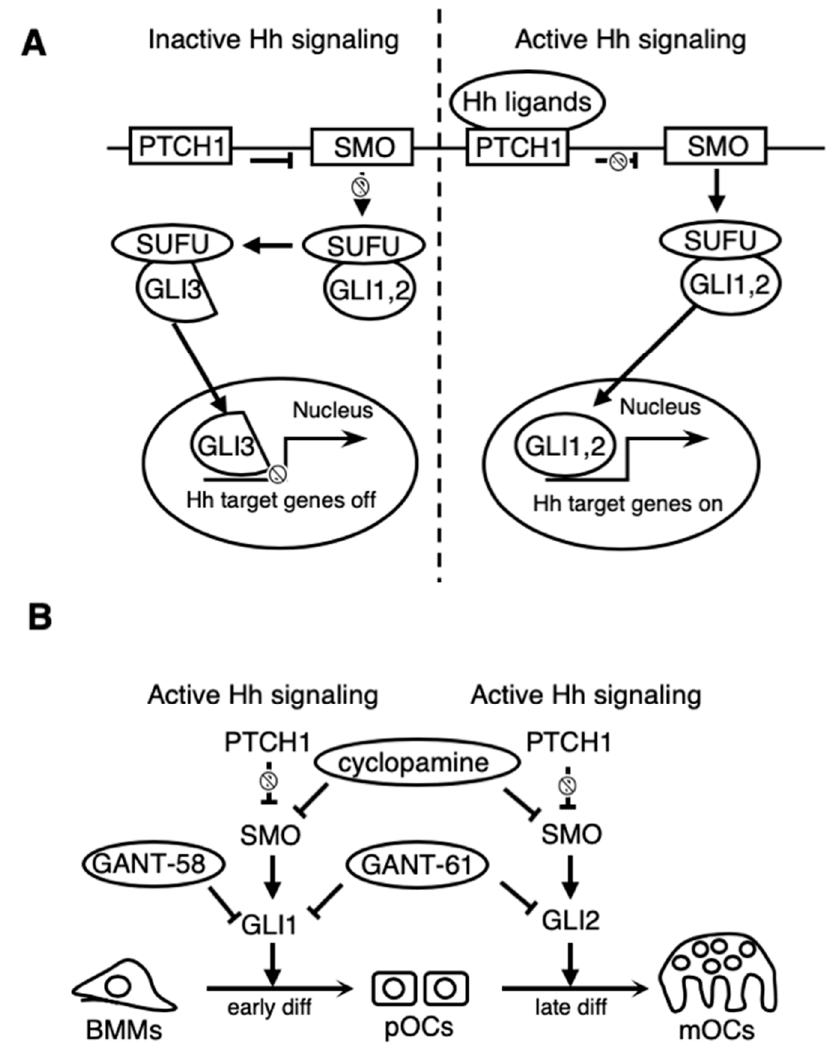
Figure 6. Schema of Hh signaling-mediated osteoclastic differentiation. ( A ) Schematic of the general Hh-signaling pathway. ( B ) Proposed model of the newly identified inhibitory mechanism on osteoclastic differentiation by Hh inhibitors. GLI1 activation is a requisite for the differentiation of bone marrow-derived macrophages (BMMs) into pre-osteoclasts (pOCs). GLI2 activation is a requisite for the differentiation of pOCs into mature osteoclasts (mOCs).